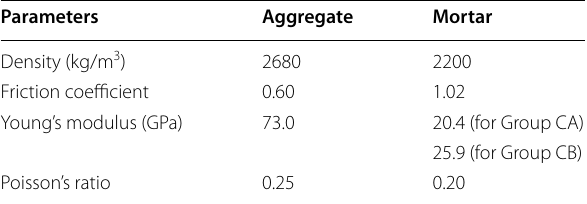
Table 5 Relevant macroscopic mechanic